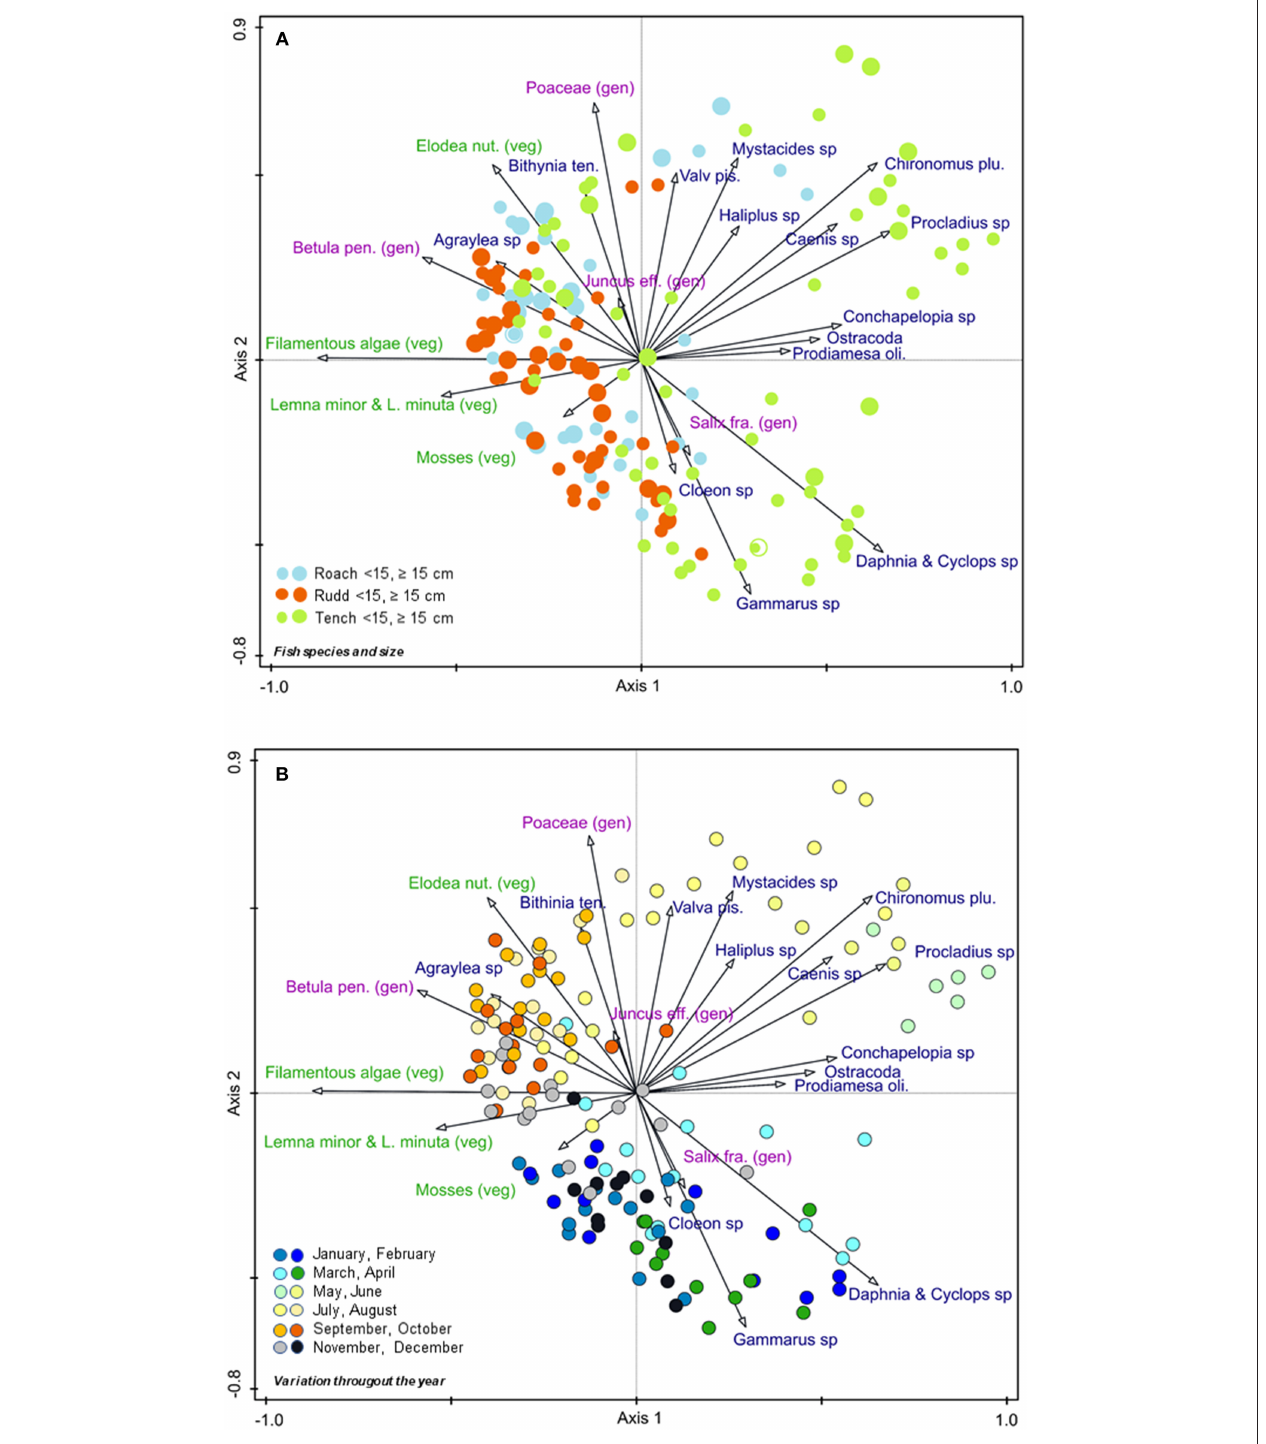
FIGURE 1 | PCoA-diagrams for the first two axes, showing the relative positions of samples and taxa. In (A) samples are classified by fish species and fish size, in (B) by month. Eigenvalues and explained variation of axis 1 and 2 are 0.178 and 17.8%, and 0.155 and 15.5%, respectively. For full names of taxa, see Table S1 . Gen, generative propagules (pink); veg, vegetative propagules (green), items in blue are invertebrates.